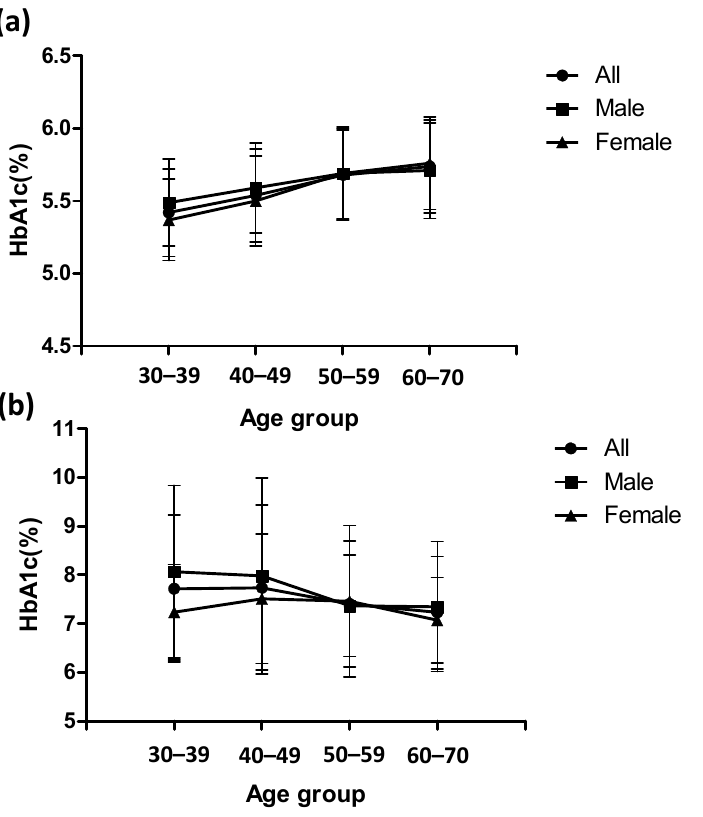
Figure 1. HbA1c levels among different age groups for HbA1c < 6.5% ( a ) and HbA1c ≥ 6.5% ( b ). Error bars indicate ± one standard deviation.